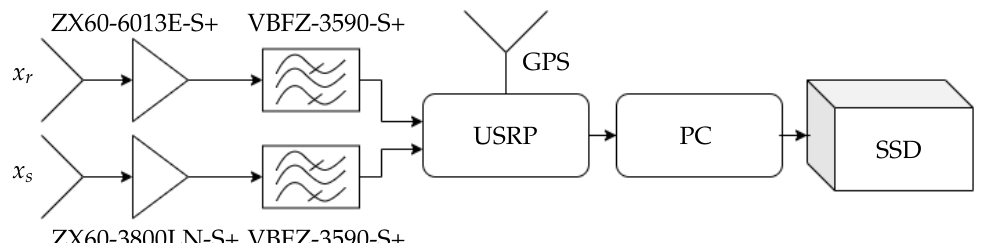
Figure 19. Recorder diagram.